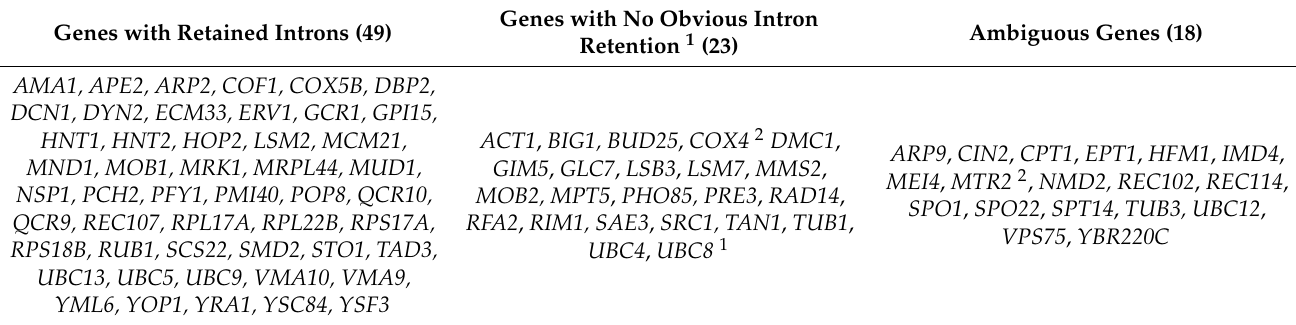
Table 1. Intron retention in spore transcripts. RNA-seq reads from sorted spores were analyzed for 90 intron-containing genes to classify them as to the efficiency of their splicing in spores. The number of genes in each splicing efficiency category is given in